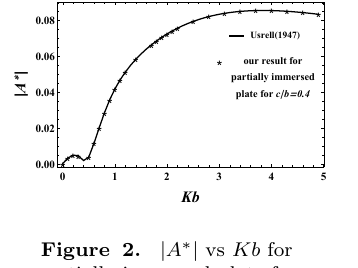
Figure 3. | A ∗ | vs Kb for submerged plate for c/b = 0 . 5 and a/b = 0 . 2 .